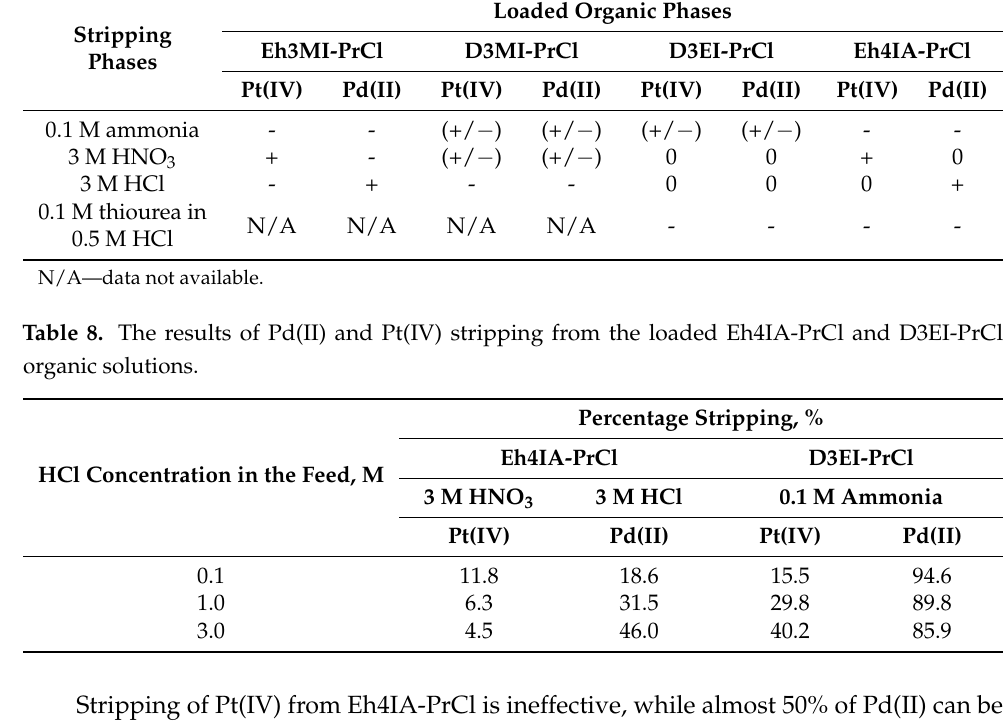
Table 7. Comparison of stripping phases used in the research, (+) correct stripping and good phase disengagement, (+/ − ) correct stripping with the emulsion disappearing over time, (-) a stable emulsion is formed and (0) no stripping and good phase disengagement. Loaded Organic Phases Stripping Eh3MI-PrCl D3MI-PrCl D3EI-PrCl Phases - -